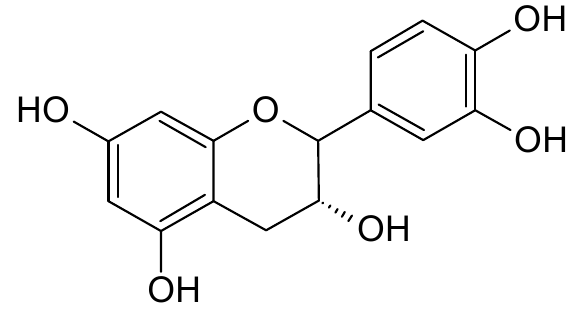
Figure 9. The structure of epicatechin.